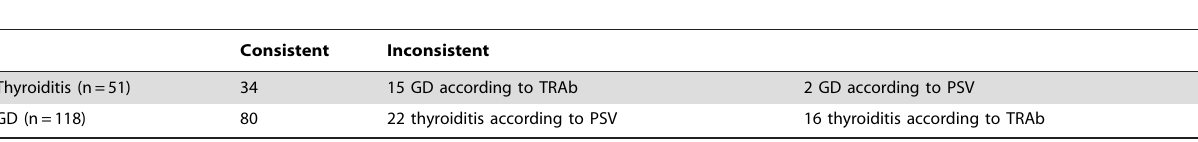
Table 4. Accordance analysis between TRAb and PSV in the prospective study.